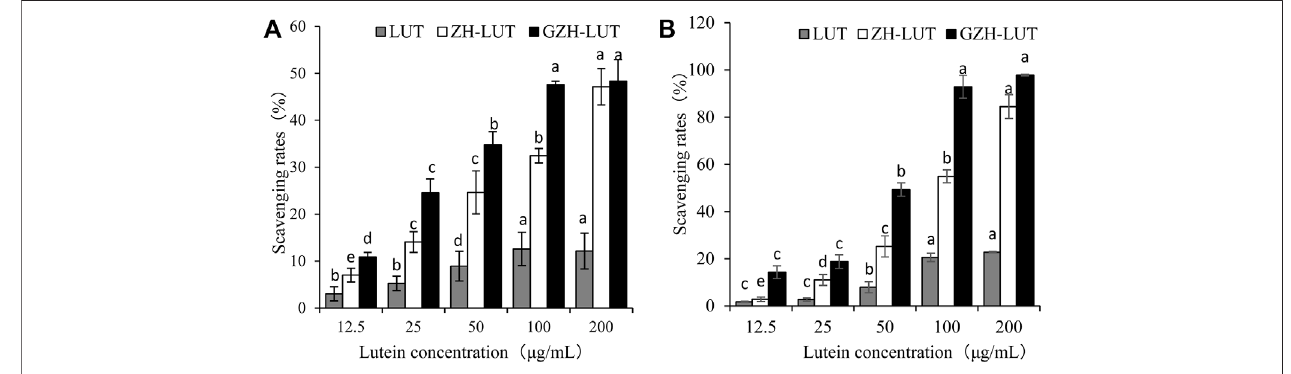
FIGURE 10 | Rates of DPPH radical (A) and hydroxyl radical (B) scavenging by lutein, ZH-LUT nanoparticles and GZH-LUT nanoparticles.